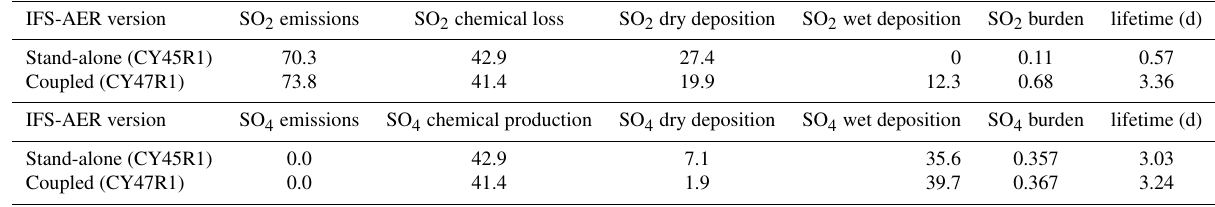
Table 2. Global budget for 2017 (annual mean) of SO 2 and SO 2 as simulated by IFS-AER standalone and coupled with IFS-CB05 (fluxes are expressed in TgSyr − 1 ; burden is expressed in